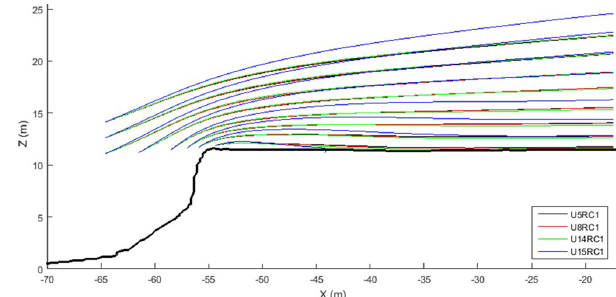
Figure 7. Streamlines of mean velocity for various cases with roughness configuration RC1.